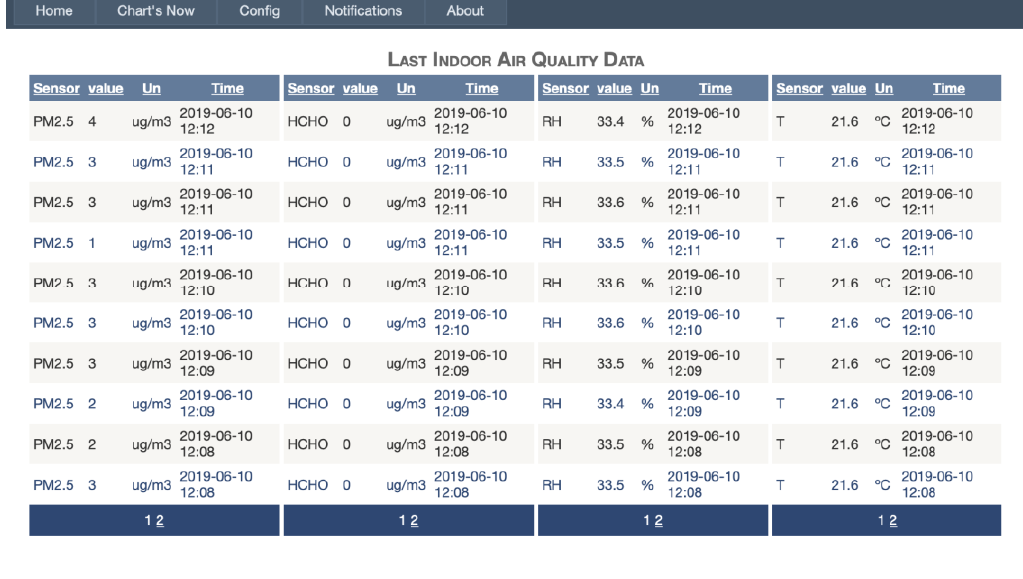
Figure 5. AirPlusWeb — last collected data.